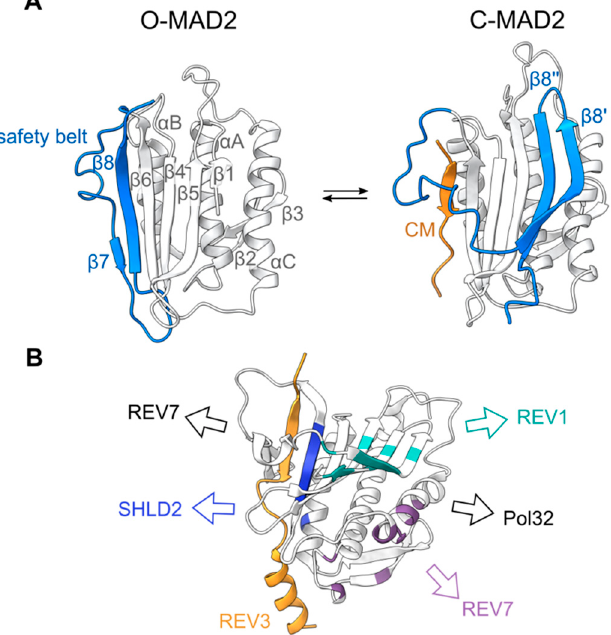
Figure 1. ( A ) Structures of human MAD2 in an open (PDB 1DUJ) and closed (PDB 1KLQ) confor- mation [24,26]. The safety belt and CM are highlighted in blue and orange, respectively. ( B ) In addition to the canonical safety belt-CM binding site (shown here by the REV3 CM; PDB 6BC8), REV7 interacts with other protein partners through additional interfaces. Important residues for these interactions between human REV7 and REV1 (cyan), REV7 (purple) and SHLD2 (blue) are high- lighted. Additional interaction surfaces characterized in yeast Rev7 are shown in black [30].